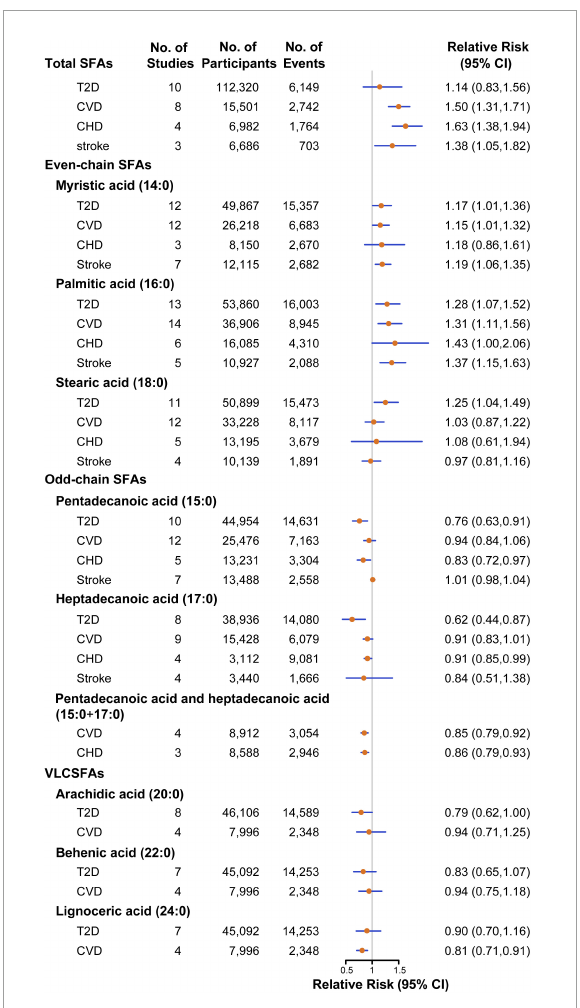
FIGURE2 Pooled relative risks of T2D, CVD, CHD, stroke comparing the highest with the lowest tertile of SFA biomarkers. CHD, coronary heart disease; CI, confidence interval; CVD, cardiovascular disease; SFAs, saturated fatty acids; T2D, type 2 diabetes; VLCSFAs, very-long-chain